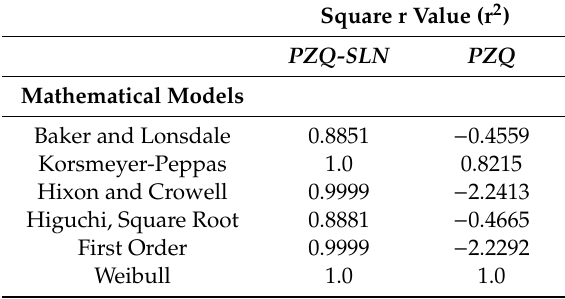
Table 1. Coe ffi cient of in vitro release of di ff erent mathematical models for formulations PZQ, SLN, and